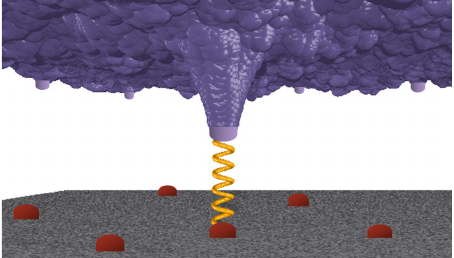
FIG. 1. Schematic representation of the system. The membrane (purple) that anchors receptors (yellow) fluctuates above the target surface. The membrane is locally deformed when the receptor forms a bond with the surface ligand